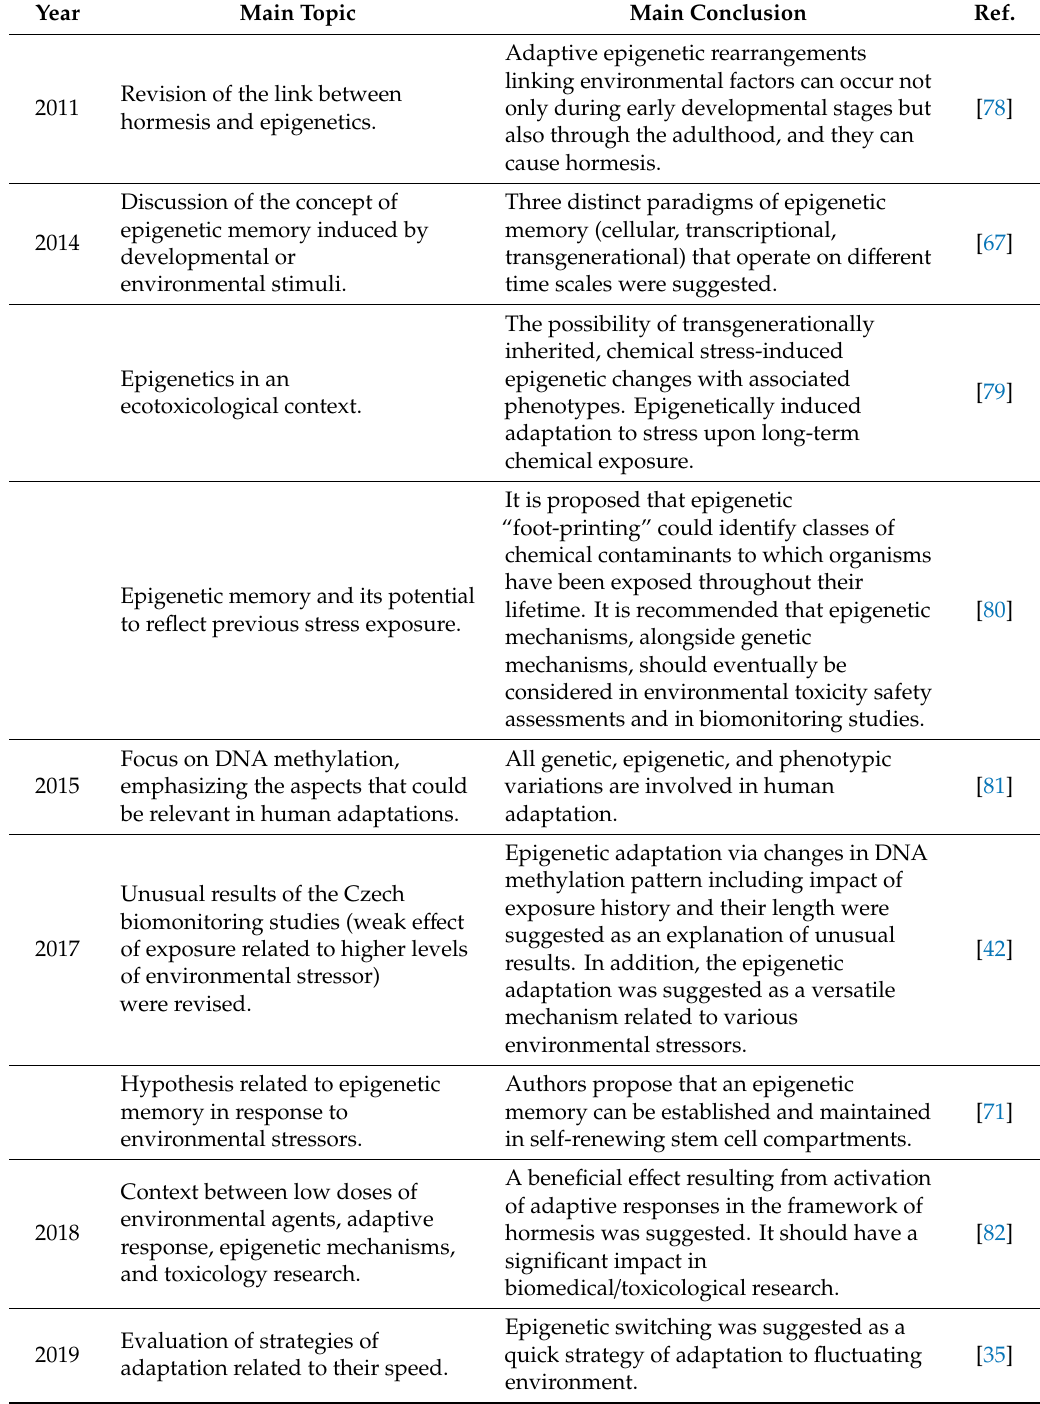
Table 2. Overview of the key reviews or hypotheses concerning the role of epigenetic changes in adaptation to the